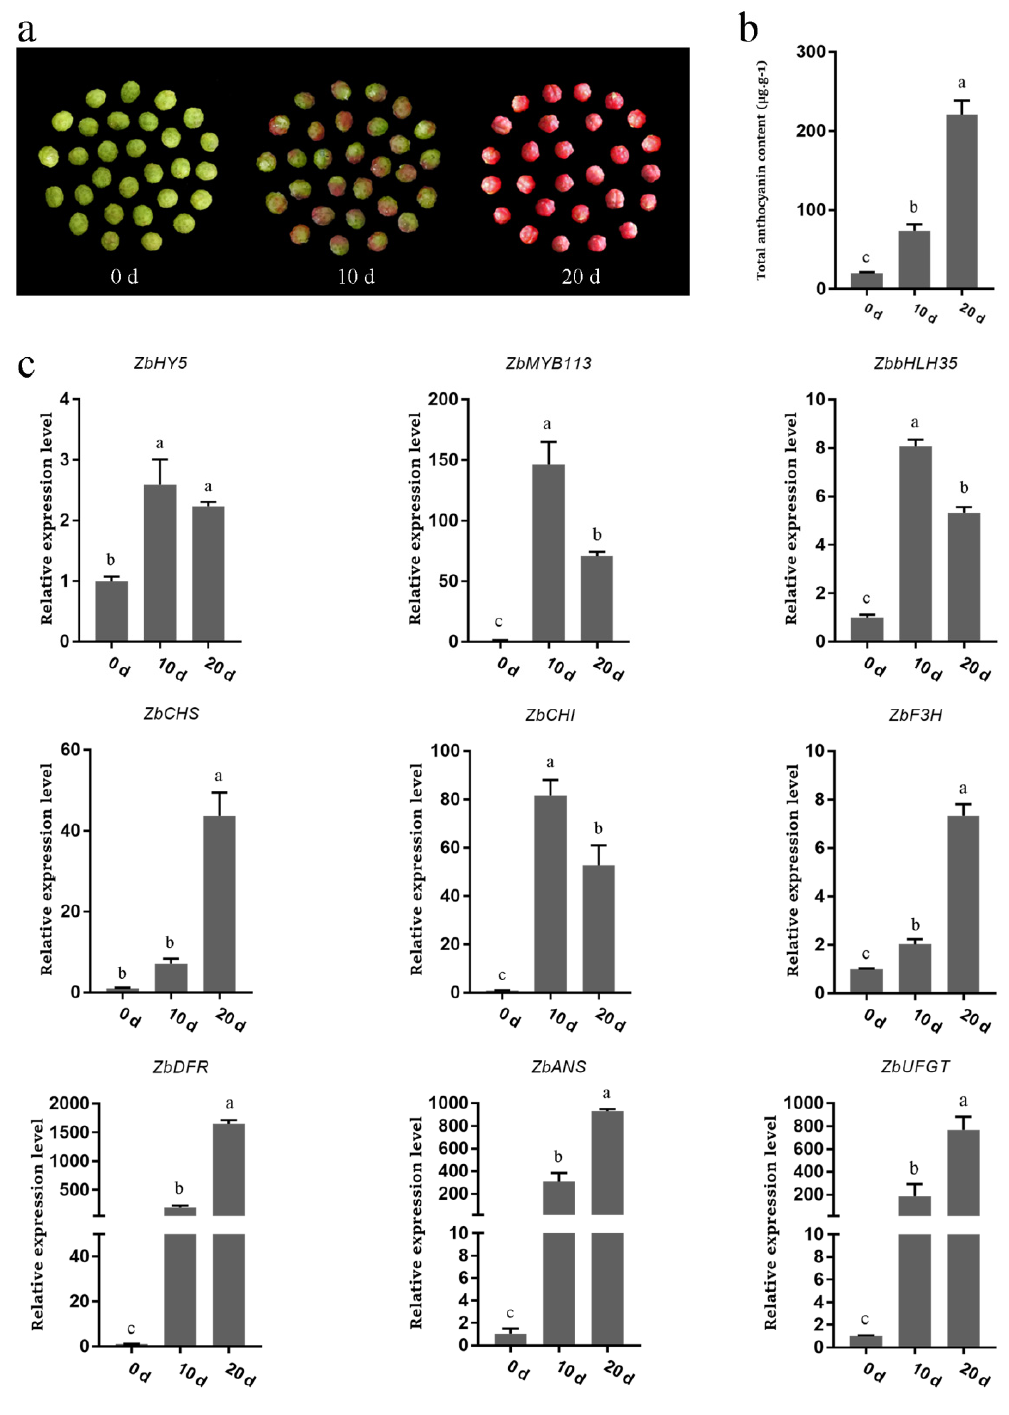
Figure 3. Total anthocyanin content and gene expression changes after the unbagging of Z. bungeanum fruit. ( a ) Pictures of Z. bungeanum fruit at 0 days (0 d), 10 days (10 d), and 20 days (20 d) after unbagging. ( b ) Total anthocyanin content in 0 d, 10 d, and 20 d fruit. ( c ) The expression of the transcription factor genes ( ZbHY5 , ZbMYB113 , ZbbHLH35 ) and structural genes ( ZbCHS , ZbCHI , ZbF3H , ZbDFR , ZbANS , ZbUFGT ) related to anthocyanin synthesis in 0 d, 10 d, and 20 d fruit. Different lowercase letters indicate significant differences among treatments according to one-way ANOVA test ( p < 0.05).